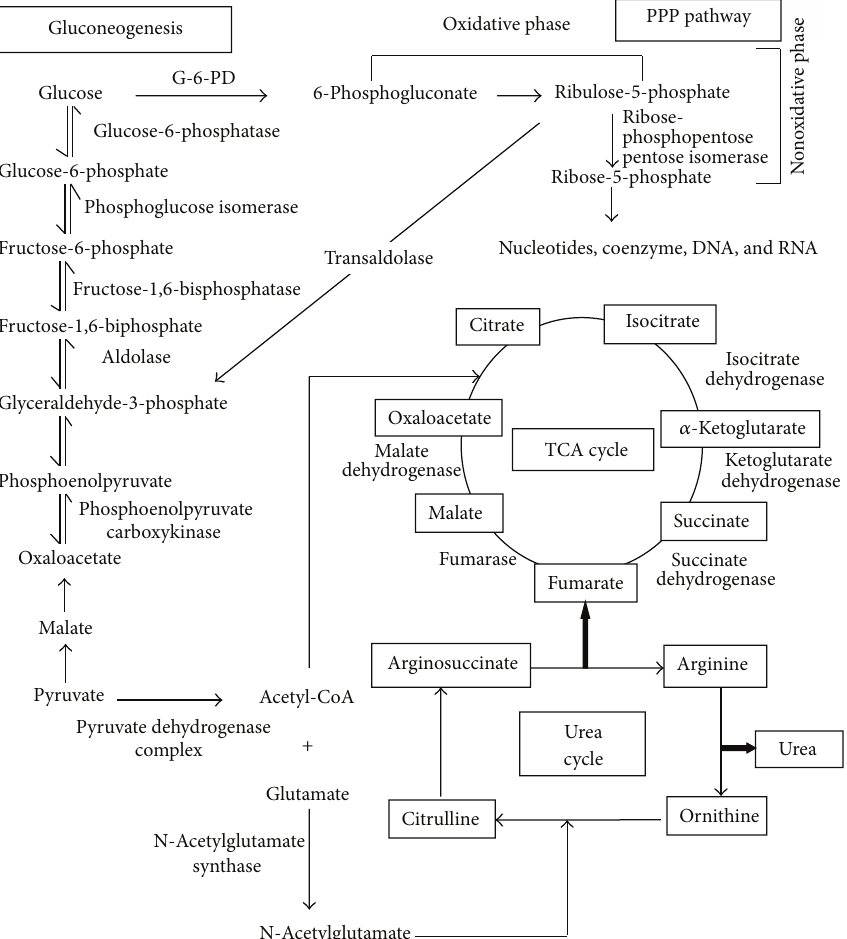
Figure 1: Interlinking between various metabolic pathways (gluconeogenesis, Krebs cycle, urea cycle, and pentose phosphate) and various enzymes responsible for